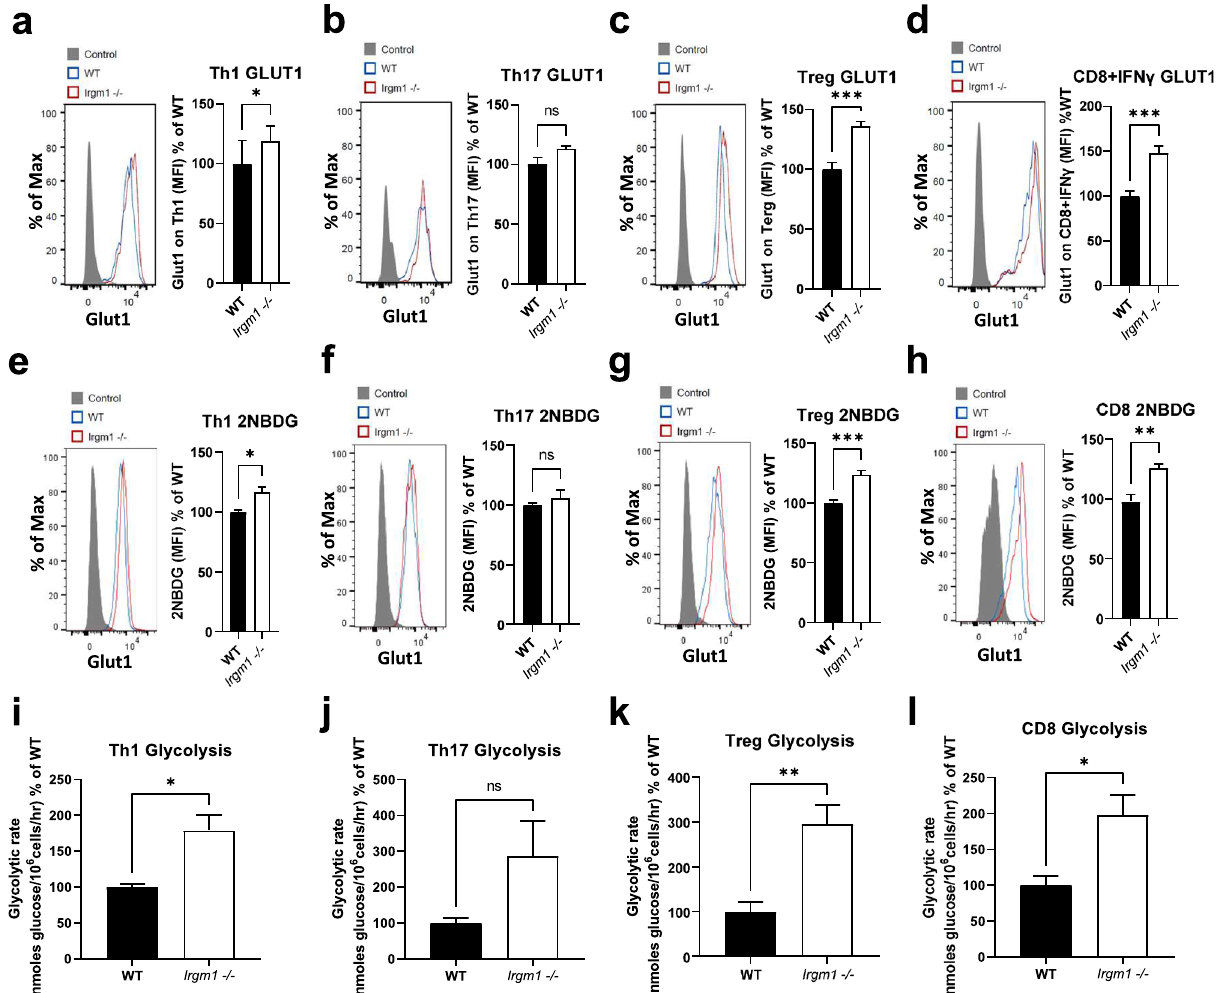
Figure 5. Irgm1 deficiency is associated with increased T cell glucose metabolism. ( a-d ) Splenocytes were isolated from WT and Irgm1 −/− mice, stained and analyzed by flow cytometry for Glut1 expression on CD4 + IFNγ + (Th1 cells) ( a ), CD4 + IL-17 + (Th17 cells) ( b ) , CD4 + CD25 + Foxp3 + (Treg cells) ( c ) and activated CD8 + IFNγ + cells ( d ) . ( e–h ) Isolated CD4 + and CD8 + T cells from WT and Irgm1 −/− mice were differentiated or activated in vitro and uptake of glucose analog 2NBDG was measured flow cytometrically in Th1 ( e ), Th17 ( f ), Treg ( g ) and CD8 + T cells ( h ). ( i-l ) Cells were assayed for glycolytic activity by monitoring the formation of tritiated water from glucose in Th1 ( i ), Th17 ( j ), Treg ( k ) and CD8 + T cells ( l ). Data pooled from two independent experiments ( n = 6–8 ); error bars represent ± SEM. T-test with T-test with Welch’s correction was used to compare groups after confirming normality using the Shapiro–Wilk test. * p < 0.05, ** p < 0.01, *** p < 0.001, ns, not